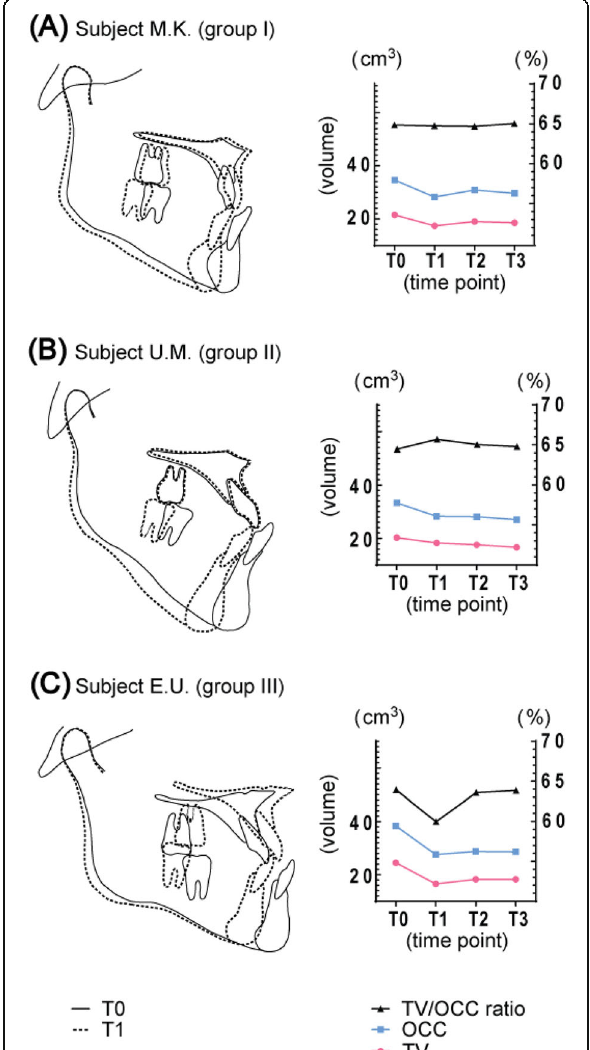
Fig. 8 Superimposition of the cephalogram tracing and transition of TV, OCC, and TV/OCC ratio. a Group I representative — Subject M.K. (female; 35 years, 2 months). Superimposition of cephalogram tracing between T0 (solid line) and T1 (dotted line). The value of the change of TV/OCC ratio from T0 to T1 and from T1 to T3 was small, and the transition of TV/OCC ratio was stable during all the experiment period. b Group II representative — U.M. (female; 25 years, 6 months). Superimposition of cephalogram tracing between T0 (solid line) and T1 (dotted line). Although the value of the change of TV/OCC ratio from T0 to T1 increased, the value from T1 to T3 got closer to TV/ OCC ratio value at T0. c Group III representative — subject E.U. (male; 26 years, 8 months). Superimposition of cephalogram tracing between T0 (solid line) and T1 (dotted line). Although the value of the change of TV/OCC ratio from T0 to T1 decreased, the value of TV/OCC ratio form T1 to T3 got closer to TV/OCC ratio value at T0